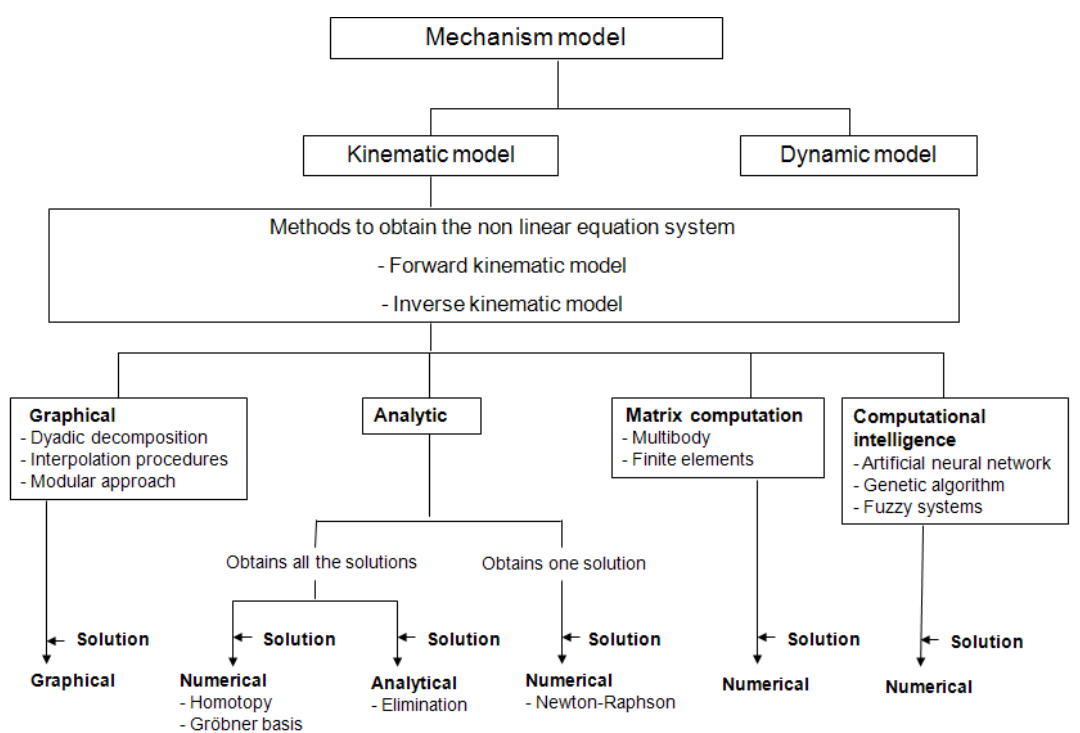
Figure 7. Scheme of different methods to modeling and solving parallel kinematic